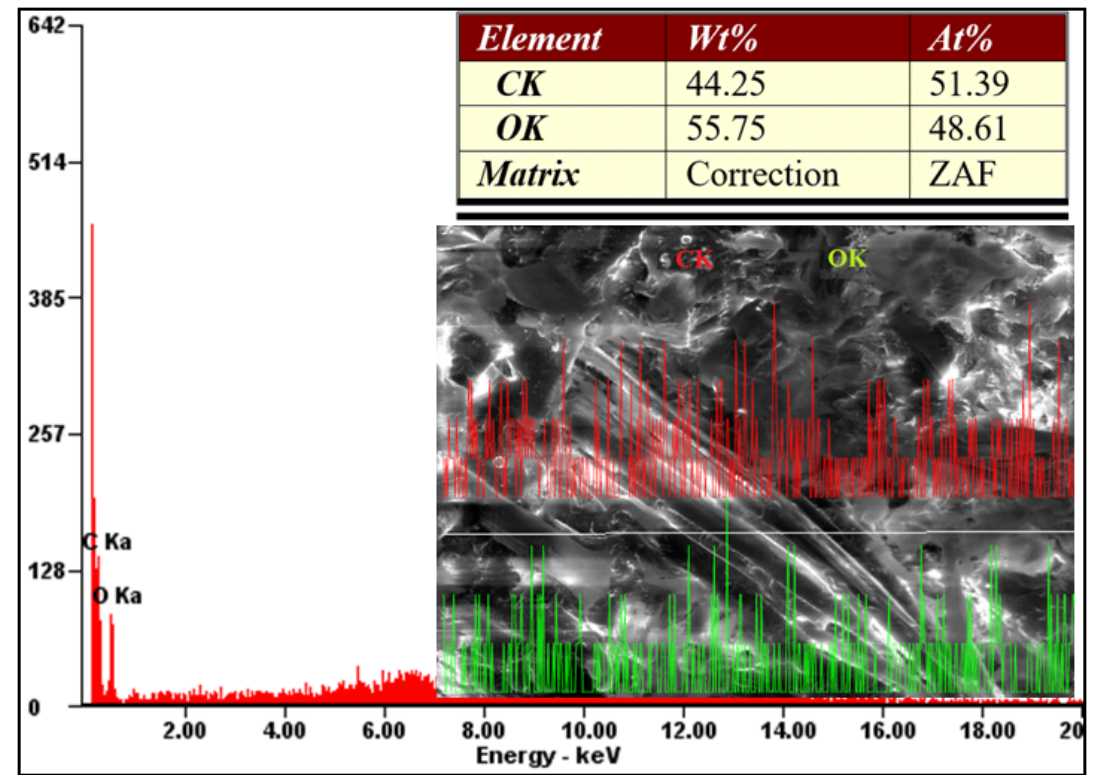
Figure 17. In-line EDX analysis for the injected sample from Arboform ® LV3 Nature ran forced with aramid fibers (kV: 30.00 Mag: 500x).